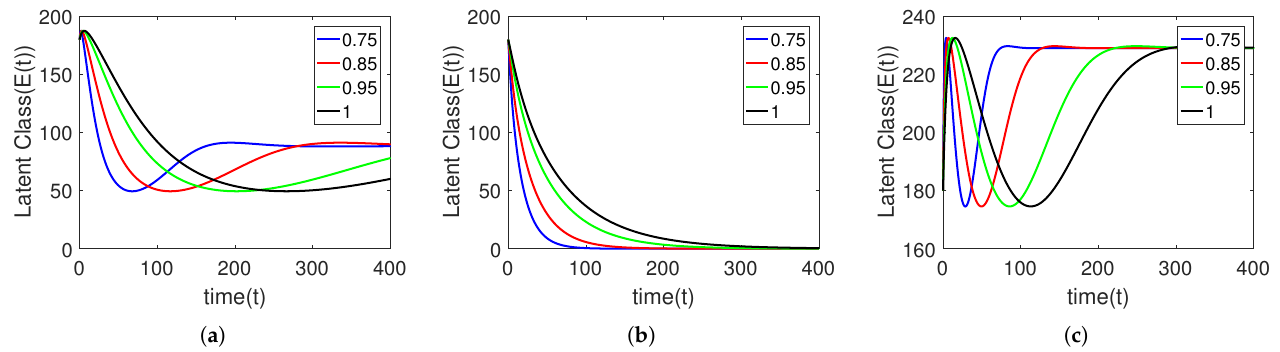
Figure 13. Graphical view ( a – c ) of Latent class on different arbitrary orders γ = 0.75,0.85,0.95,1 for initial data and time duration for TB model by taking the value of β = 0.75,0.075,1.75.